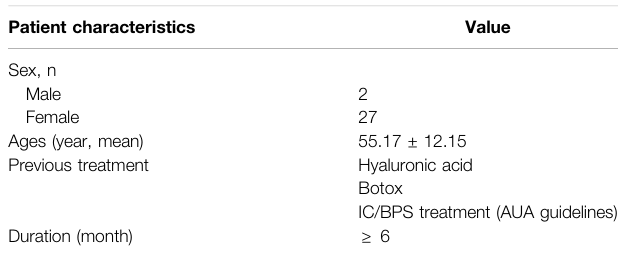
TABLE 1 | Patient background